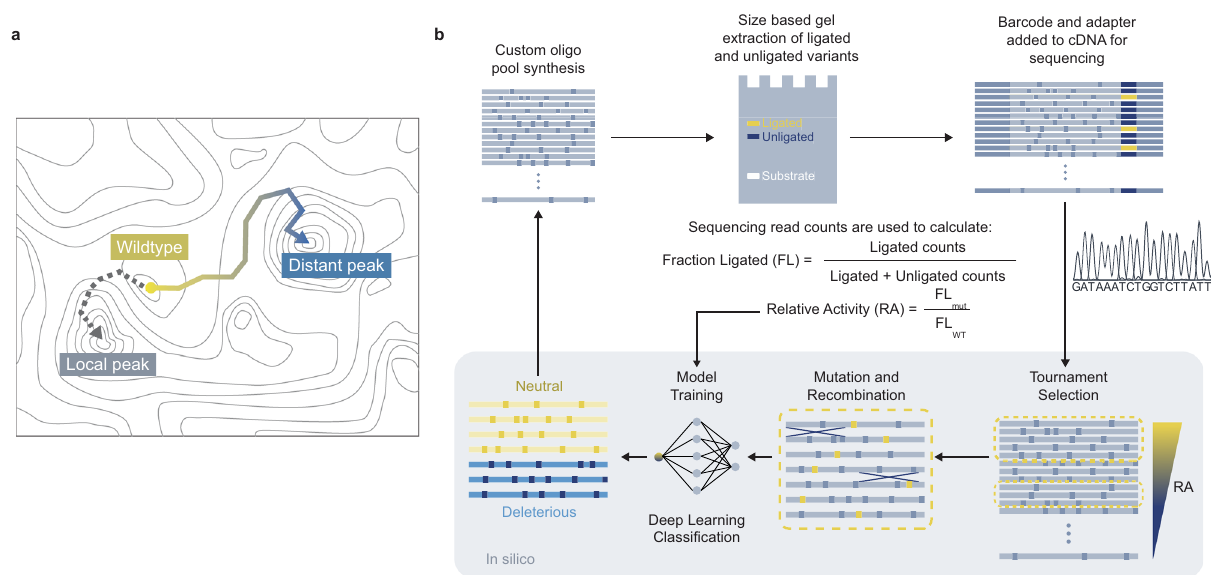
Fig. 1 | Experimental and computational pipeline for a guided exploration of theF1*Uribozyme fi tnesslandscape.a Fitnesslandscapeofaribozymeissparsely populated where peaks of activities are separated by extensive valleys of deleter- ious genotypes. Therefore, evolutionary escape from a local optimum towards a